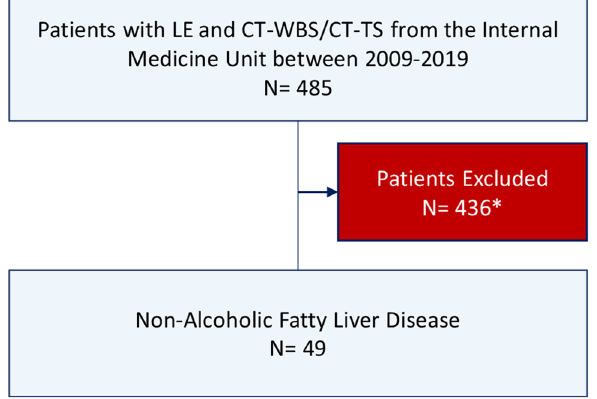
Figure 1. LE liver elastography, CT-WBS computed tomography whole body scan, CT-TS computed tomography thoracic scan. *Of the initial cohort of 485 patients, 436 were excluded for one or more of the following criteria that may have affected cardiovascular outcomes or had a different liver disease: personal history of cardiovascular disease (n = 12); active malignancy (n = 52); endocrine diseases (n = 1); excessive alcohol consumption (n = 125); viral hepatitis (n = 123); autoimmune liver disease (n = 28); toxic hepatitis (n = 10); steatogenic drugs (n = 2); iron overload (n = 8); alfa1-antitripsin deficit (n = 6); cirrhosis (n = 7); inflammatory diseases (n = 10); portal hypertension (n = 12) and other liver disease (cholestasis, cystic fibrosis, amyloidosis, Gilbert’s syndrome, paludism, thalassemia) (n =